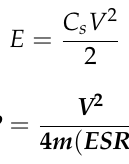
Figure 19 illustrates the E values of the EDLC assembly calculated over 500 cycles. At the 1st cycle and 90th cycle, the E resultsare steeply increased from 3.5 to 6.5 Wh/kg, respectively. From the 100th cycle to the completion of cycling, the E value is consistently maintained at 8